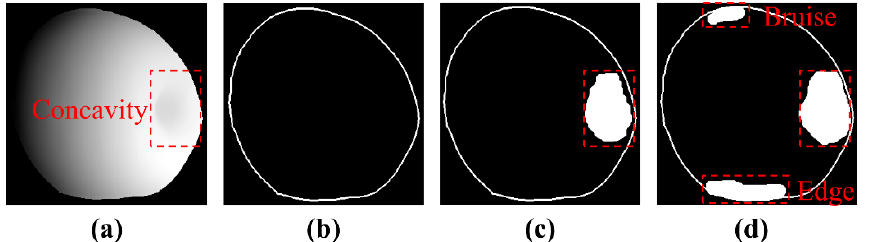
Figure 7. Identification results under different segmentation schemes. ( a ) Three-dimensional reconstruction results; ( b ) identification results for segmentation of 10; ( c ) identification results for segmentation of 120; ( d ) identification results for segmentation of 300.